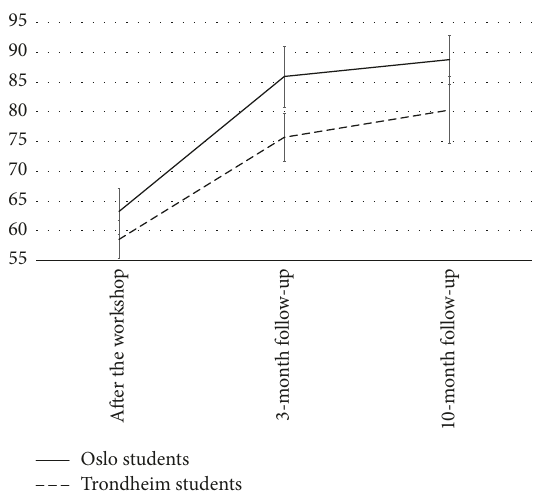
Figure 3: The course of self-efficacy for managing interpersonal events. Note . Score range is 11–110, and error bars are calculated by multiplying the standard error of the mean with 1.96. The total sample showed a linear increase in their N-SEMIE scores across